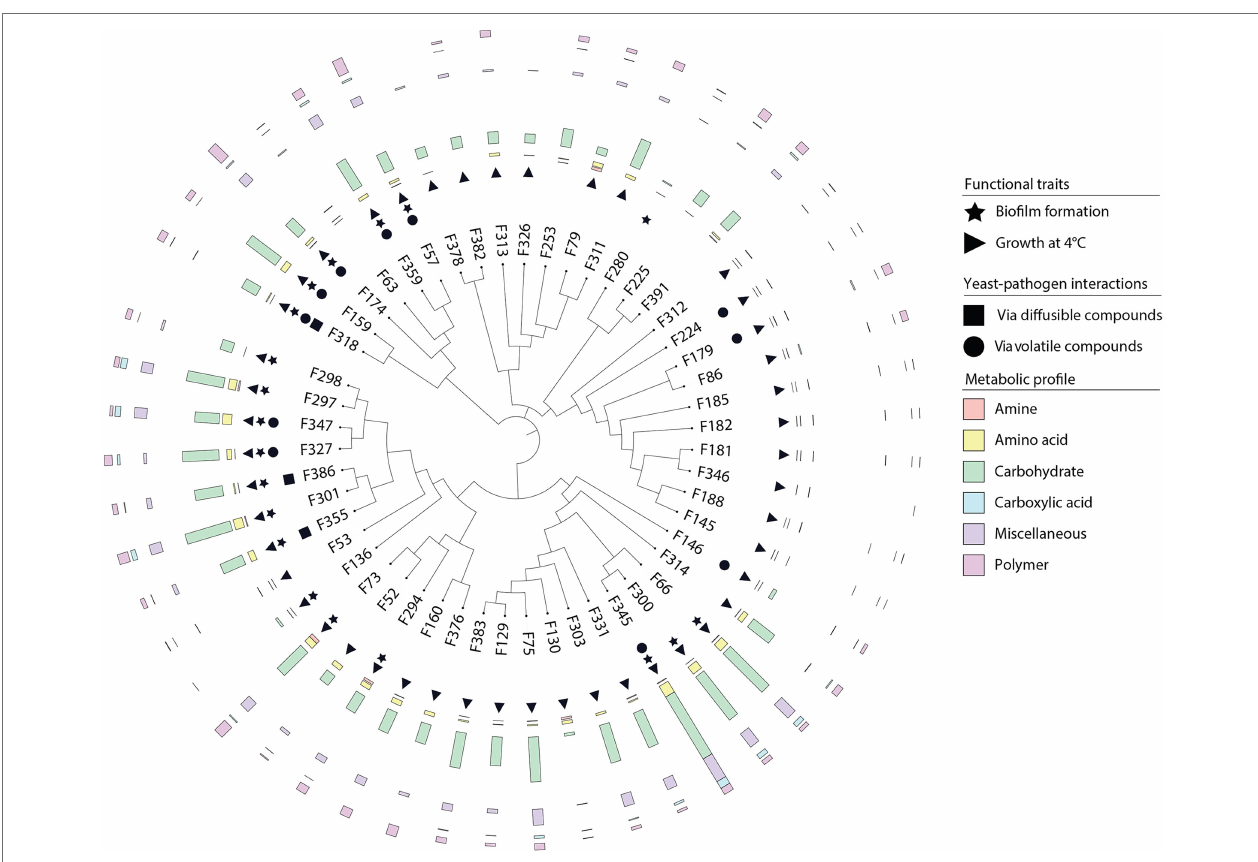
FIGURE 6 | Overview of the adaptive traits of yeasts inhabiting the wheat flag leaf. Neighbor-joining phylogenetic tree based on partial ITS sequences of yeast isolates. Isolates were screened for different traits including biofilm formation, growth at different temperatures, competition with the fungal pathogen F. graminearum via the production of agar-diffusible and volatile compounds, and substrate